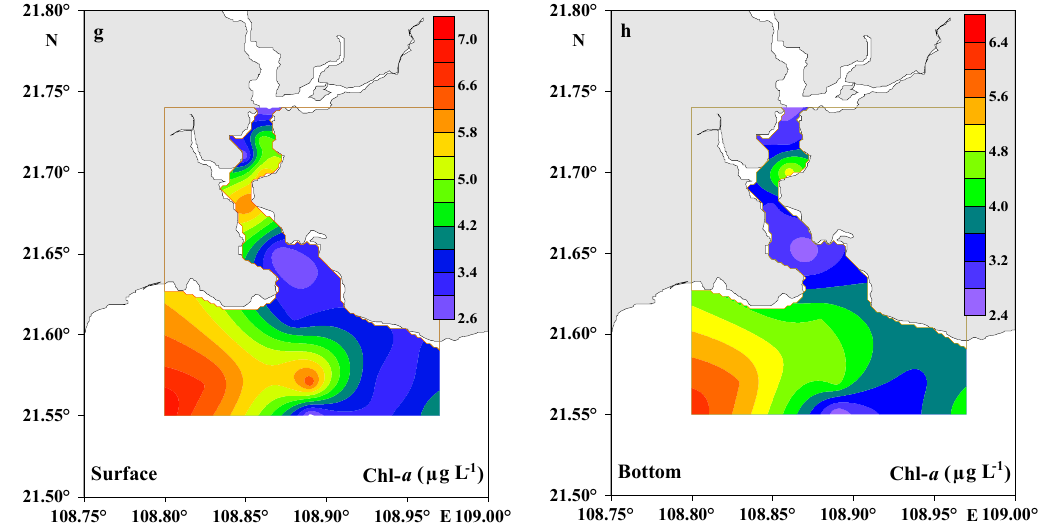
Figure 2. Distributions of temperature, salinity, pH, and Chl- a in surface and bottom waters of the Dafengjiang River estuary.